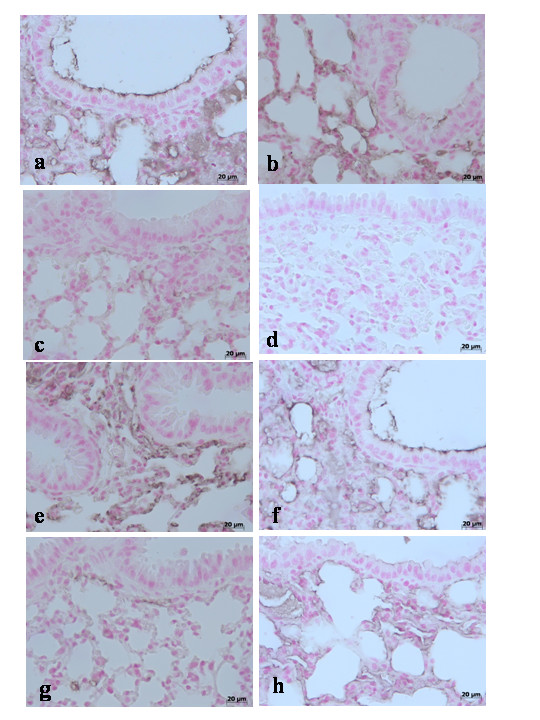
Immunohistochemical localization of Claudin-4 in the lung. In lung tissue sections collected at 24 hours from sham WT mice (a) and from sham TNF-αR1KO mice (b), Claudin-4 were uniformly and continuously distributed along the alveolar epithelium and the vascular endothelium. On the contrary, a significant disruption of immunohistochemical localization signal for Claudin-4 was observed in the lung tissues sections of carrageenan-treated WT mice at 4 h (c) and at 24 hours (d) after carrageenan. In lungs of carrageenan-treated TNF-αR1KO mice was found less irregular distribution pattern of Claudin-4 at 4 h (e) and at 24 hours (f) after carrageenan. Similarly, the treatment of WT mice with Etanercept (5 mg/kg administered s.c. 2 h prior carrageenan) were able to prevent carrageenan-induced distribution alteration of Claudin-4 at 4 h (g) and at 24 hours (h) after carrageenan. Figure is representative of at least 3 experiments performed on different experimental days.